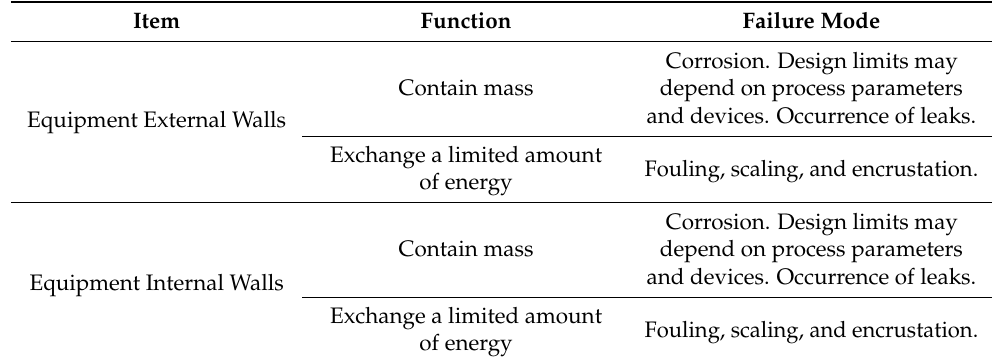
Table 2. Failure modes of boundaries and interfaces of process nodes.